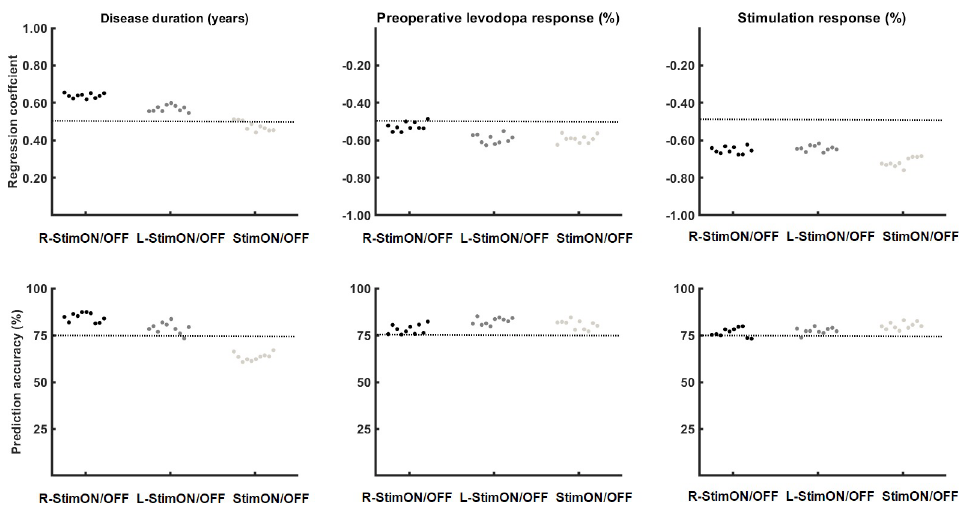
Fig 7. Prediction coefficients and the accuracy of disease duration, the levodopa and stimulation responsiveness. The 10-fold cross validated SVR results are shown separately for validation of each factor predicting the effect of the right (R-StimON), left (L-StimON), and both sided (StimON) stimulation on balance.